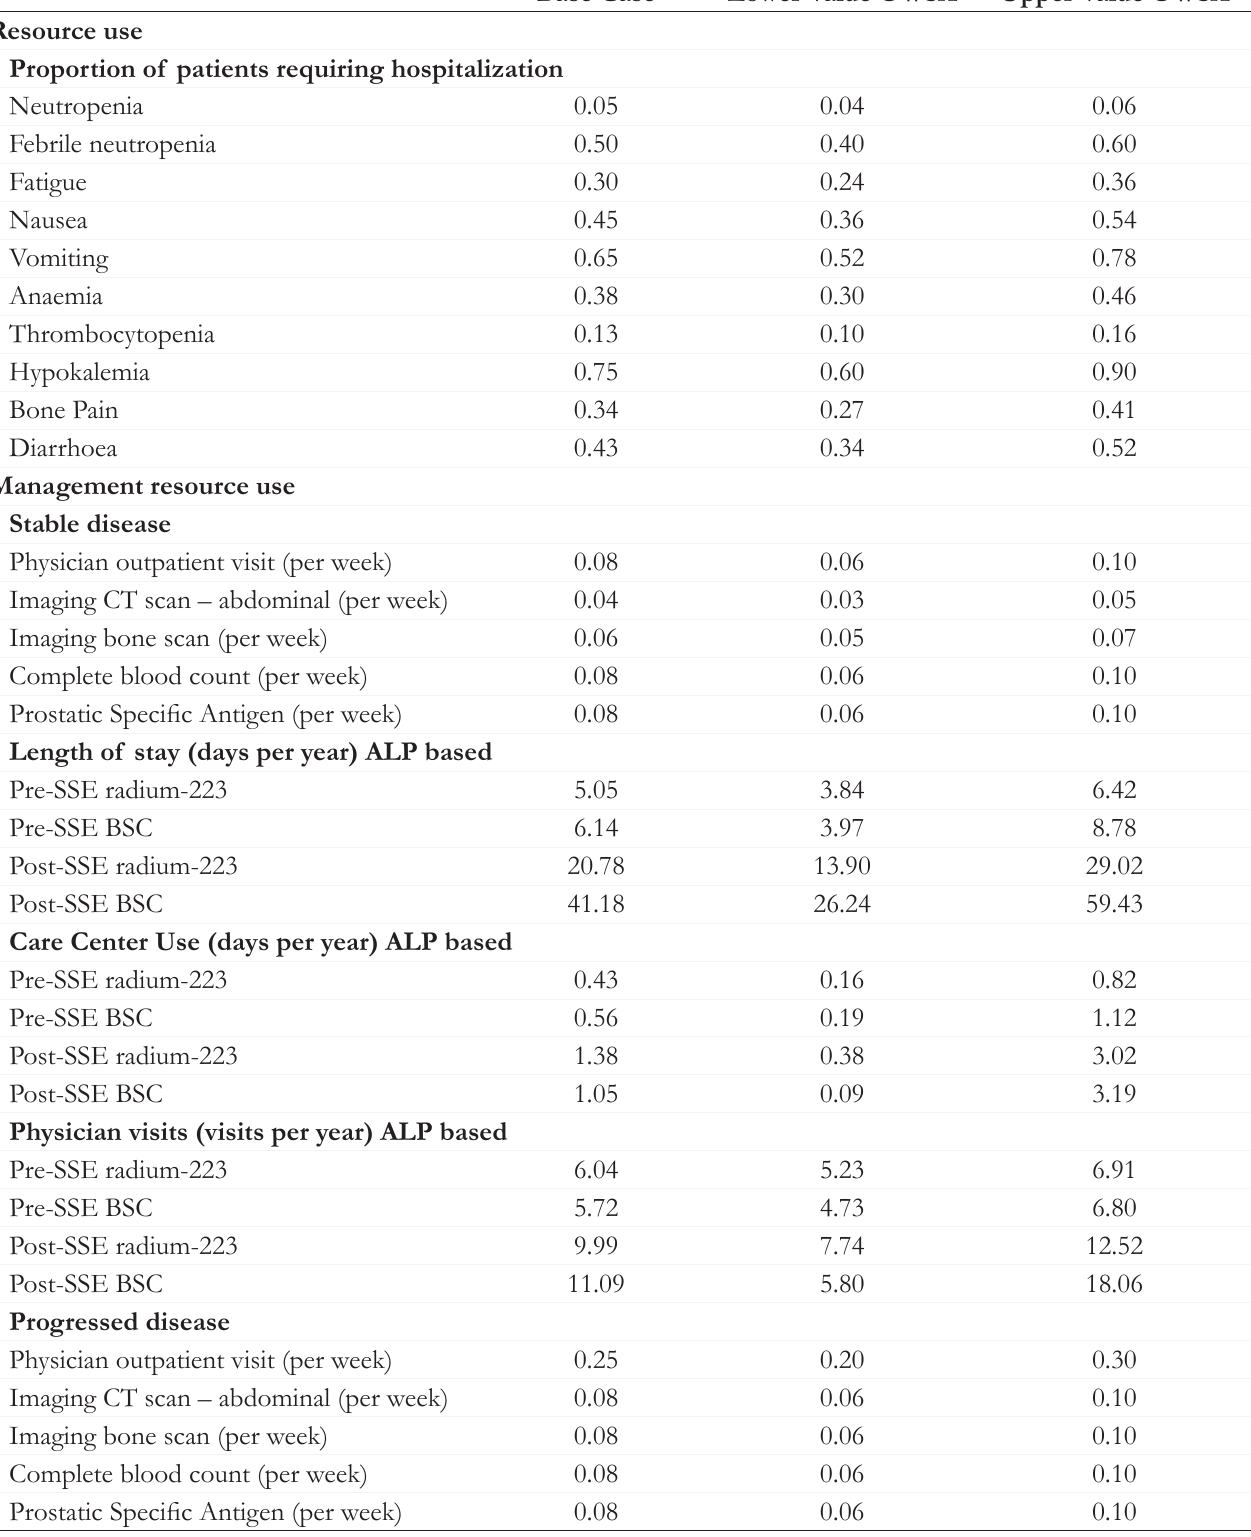
Table 3. Resource Use and Unit Costs Resource